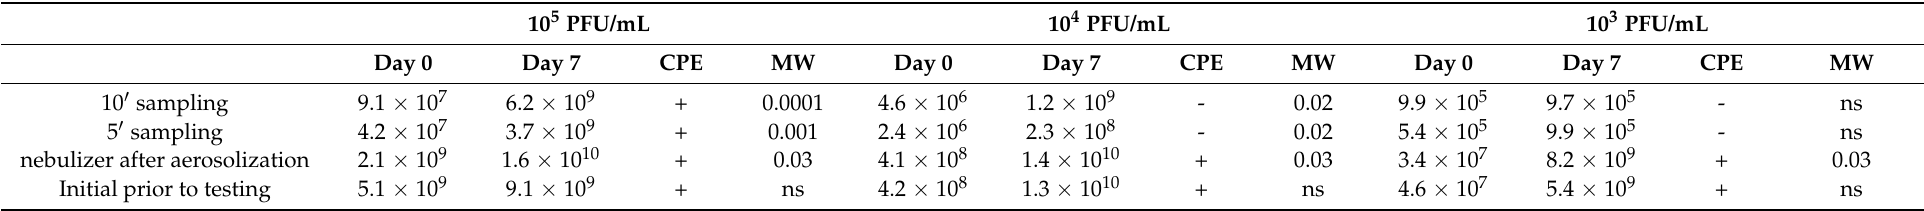
Table 1. Viral load (average viral copies for ml) at day 0 and at day 7. The data for 5 and 10 min of sampling, from the residual liquid in the nebulizer, and for the initial dilution prior to testing are reported. Cytopathic effects (CPE) and p -value from the results of Mann–Whitney test (MW) are also shown. ns = not significant statistical